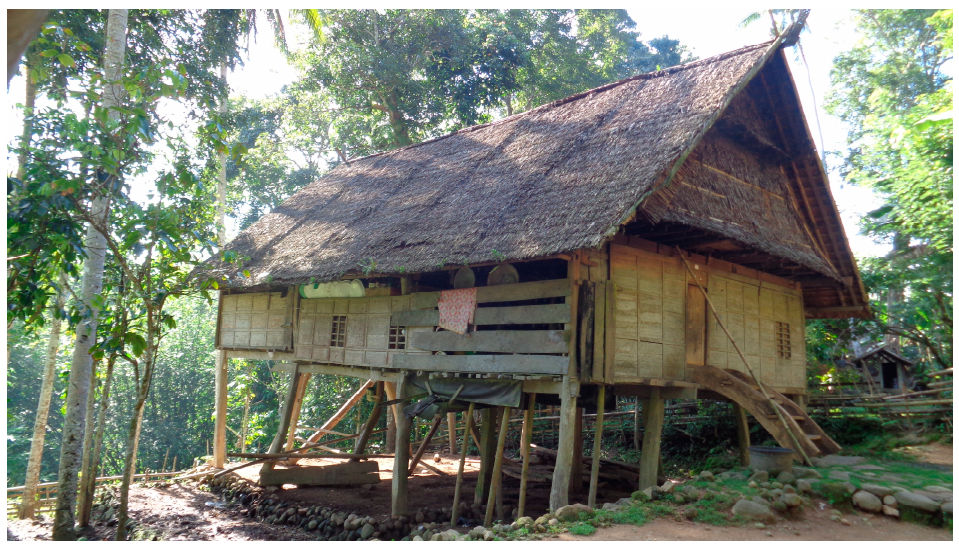
Figure 1. Ammatoan Wood House.